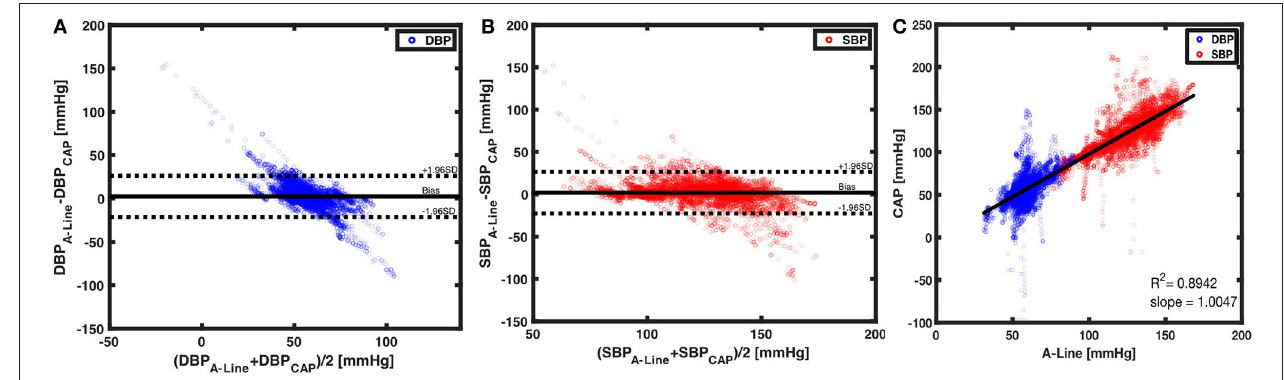
FIGURE 6 | Beat to beat BP comparison using Bland-Altman method and linear regression. (A) With 14,645 paired data points of DBP (blue circles), a mean bias of 2.3842 (solid black line) and an SD of 12.1908 were calculated. The dotted black lines are the upper (26.2782) and lower ( − 21.5098) 95% limits of agreement. On the other hand, (B) 14,674 paired measurements of SBP (red circles) were compared. The mean bias of 1.9153 (horizontal black solid line) and an SD of 12.5525 were calculated. The 95% limits of agreement ranged from − 22.6876 to 26.582. (C) The CAP sensor was compared against the A-Line using a linear regression model over 29,319 data points from valid 60-s segments. A linear fit slope of 1.0047 shows the two measurements in good correlation.